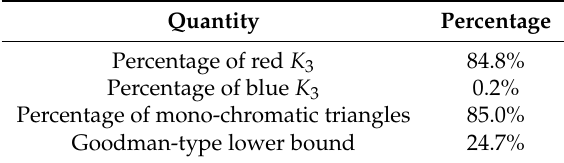
Table 8. Percentages of monochromatic triangles for the country